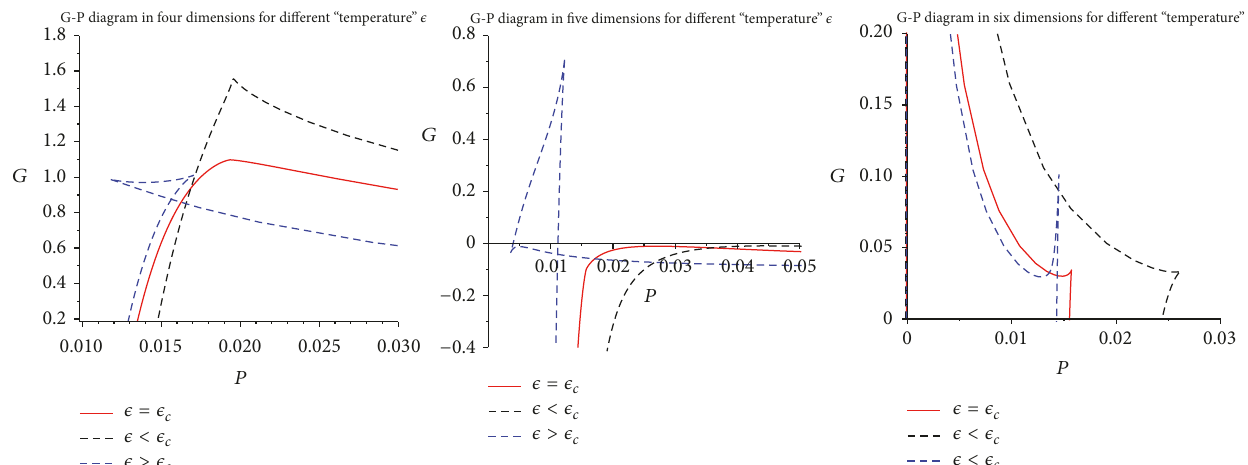
G-P diagram in four dimensions for different “temperature”  G-P diagram in five dimensions for different “temperature”  G-P diagram in six dimensions for different “temperature”  1.8